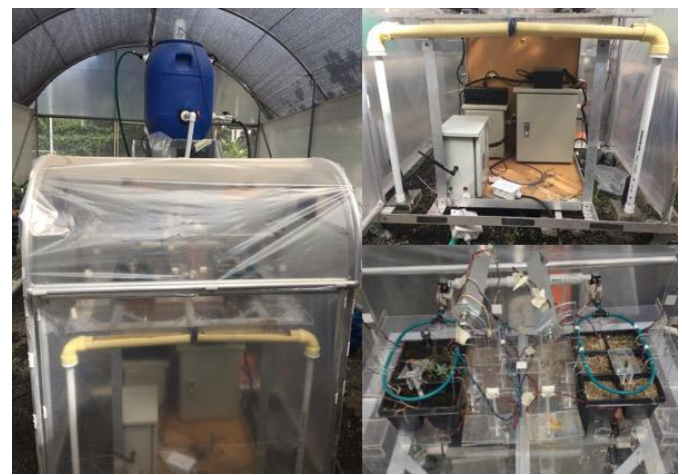
Figure 11. Instrumented cyber-physical greenhouse testbed.